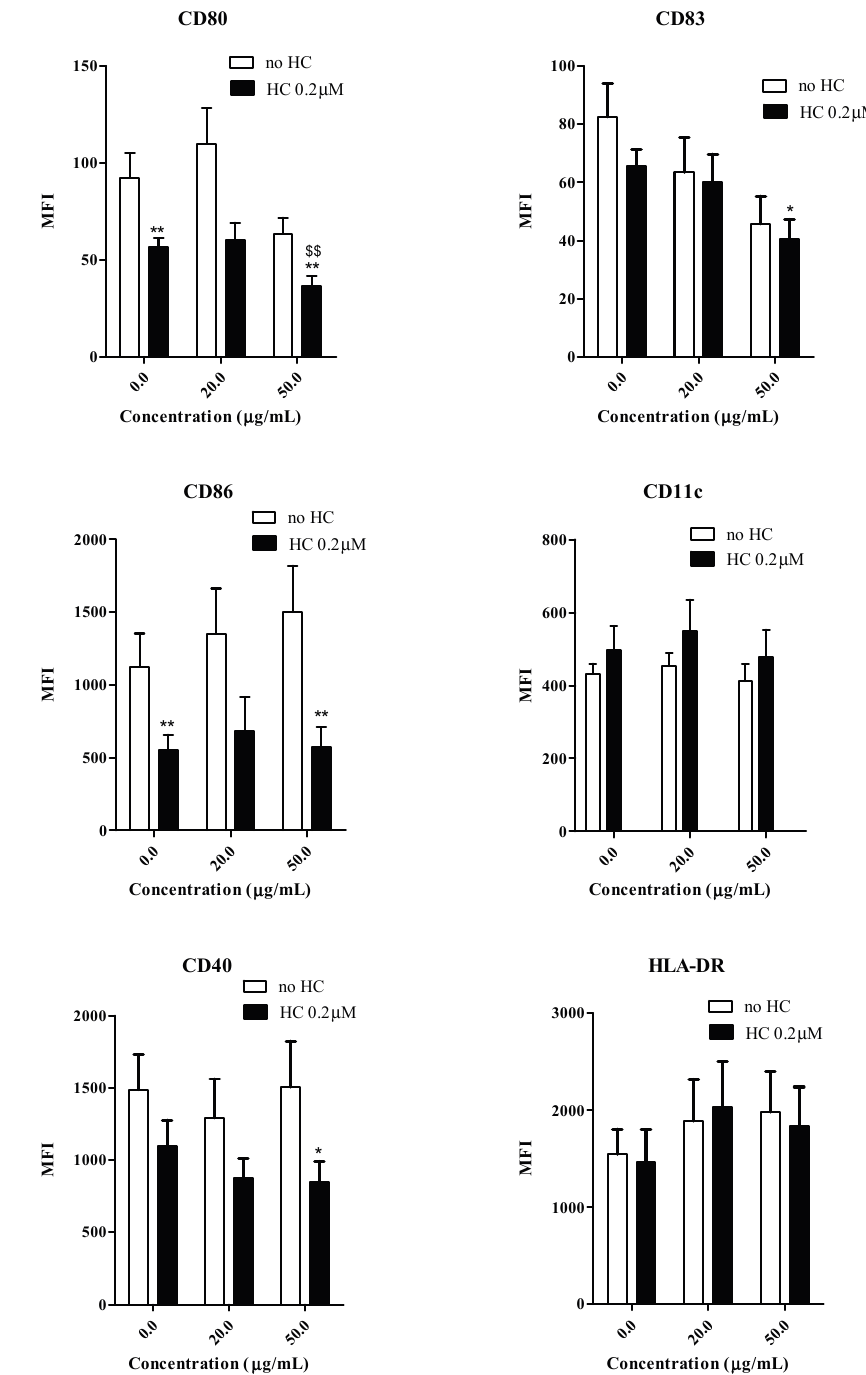
Figure 6. Combined effects of gallic acid and hydrocortisone on the expression of the functional markers from monocyte-derived dendritic cells (moDC) ( n = 10). The open bars represent the cells were added with gallic acid alone (0, 20 and 50 μ g/mL) and the solid bars represent the cells added with gallic acid (0, 20 and 50 μ g/mL) and hydrocortisone HC (0.2 μ M). * and ** indicate p < 0.05 and p < 0.01, respectively, when compared the control level of the cytokine production or surface marker expression from cells without incubating with DC-inducing cytokine cocktail. $$ indicate p < 0.01, respectively when compared the control level of the cytokine production or surface marker expression cells with HC and without incubating with DC-inducing cytokine